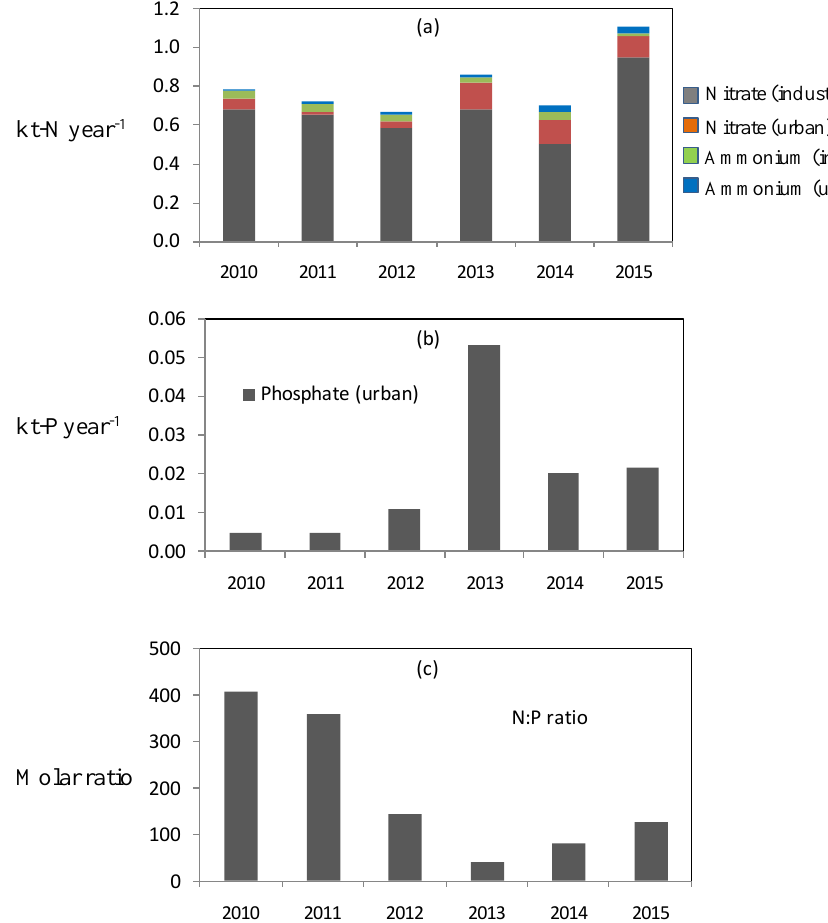
Figure 9. Loads of inorganic nitrogen ( a ) and phosphate ( b ) released from urban and industrial wastewaters in the north-western sector of the Alboran Sea. The N:P molar ratio in this effluent is also shown ( c ).